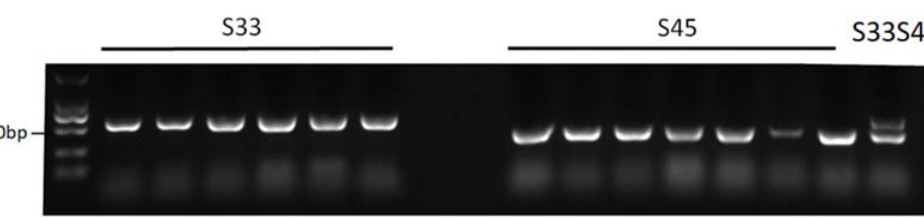
Figure 9. PCR amplification of two sets of primers (TF33 ‐ F/TF45 ‐ F/TS ‐ R) in 14 cabbage